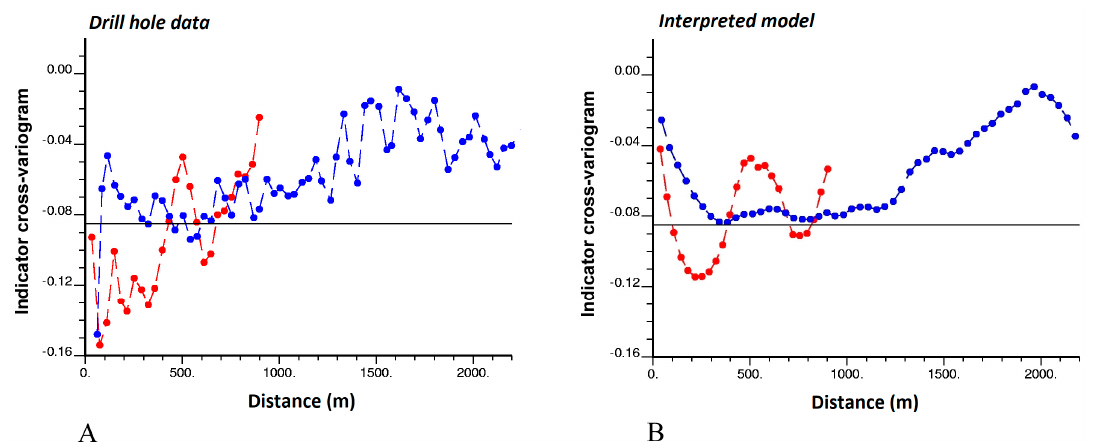
Figure 8. Indicator cross-variogram between rock types 2 (other volcanic rocks) and 3 (sedimentary rocks) along directions dipping 30° (blue) and − 60° (red) with respect to the north direction, calculated from ( A ) drill hole data, ( B ) interpreted model. Calculations consider an angle tolerance of 20° around the target directions. The same lag values have been used for both cross-variograms.